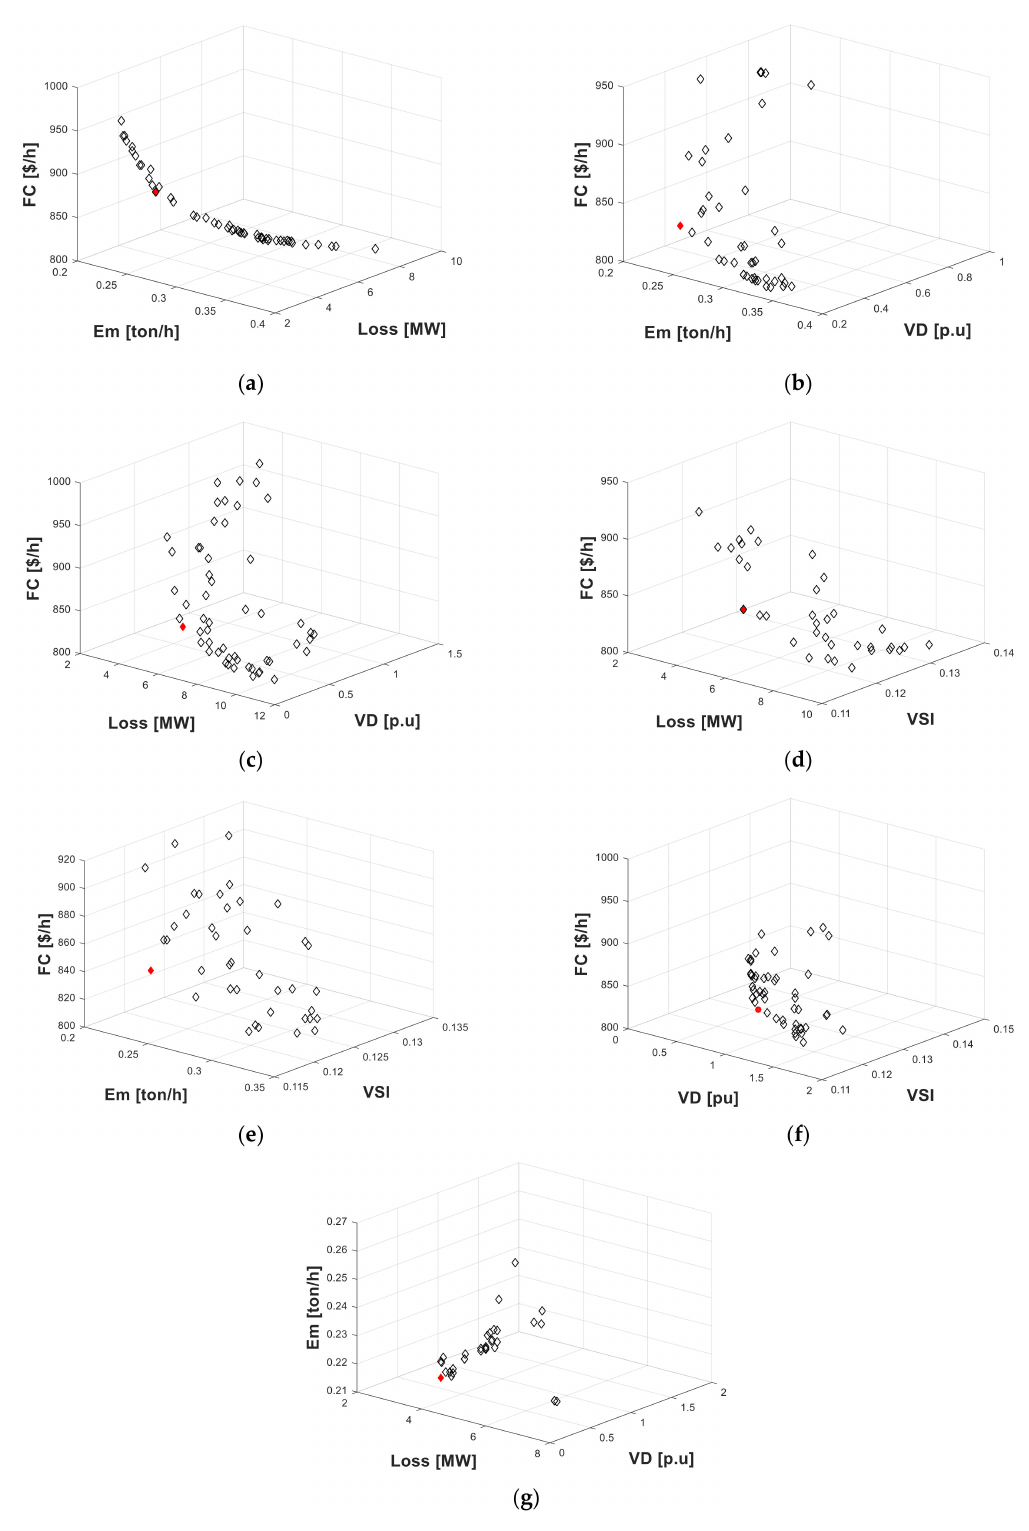
Figure 7. The convergence characteristics of the MOSMA algorithm for Cases 13–19. ( a ) Case 13, ( b ) Case 14, ( c ) Case 15, ( d ) Case 16, ( e ) Case 17, ( f ) Case 18, ( g ) Case